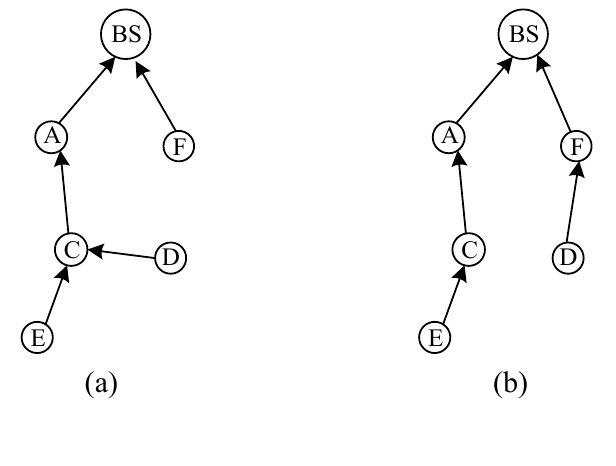
Figure 7. When a new node F joins network, routing maintenance is